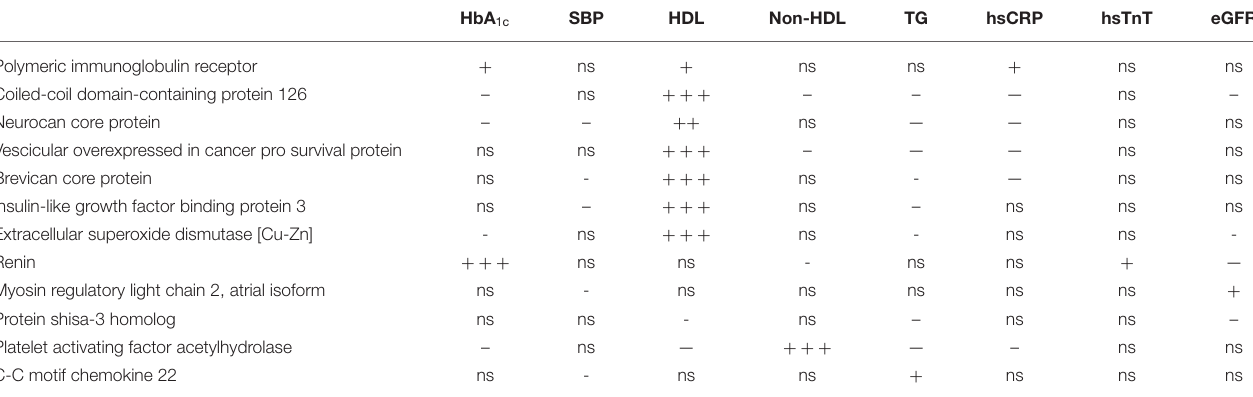
TABLE 4 | Independent association of the 12 hit plasma proteins with individual biomarkers (adjusted for sex, age and BMI) * . HbA